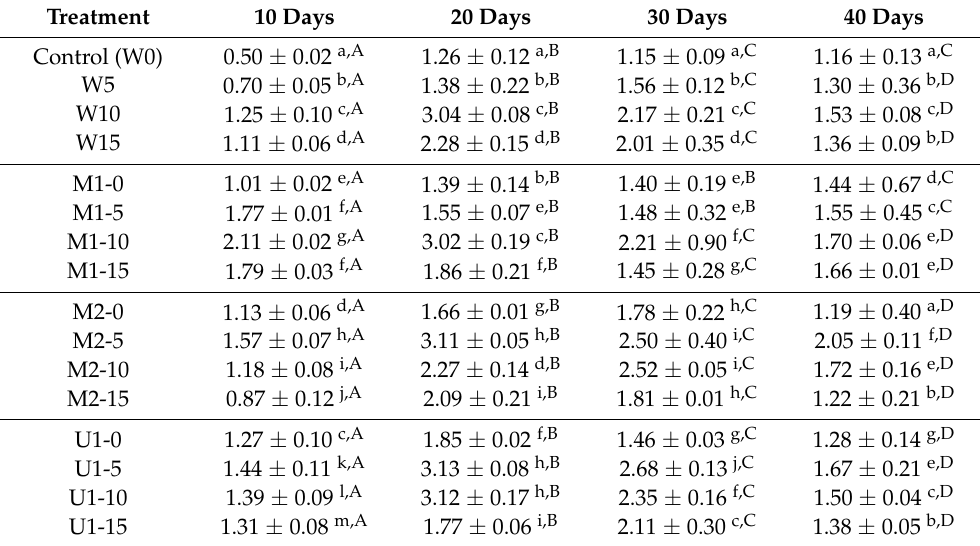
Table 2. Vanillin concentrations (% of dry weight of the pod) from cured pods treated with M and U